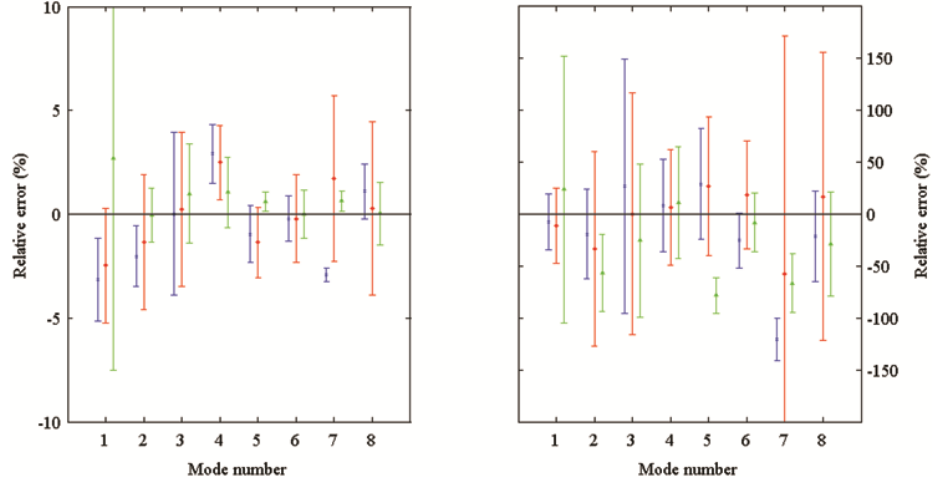
Fig. 12. Relative error of the resonant frequencies (left) and damping ratios (right) with 95% confidence bounds, FRF + TM OMAX (blue), FRF EMA (red) and FRF + XP + OMAX (green) based